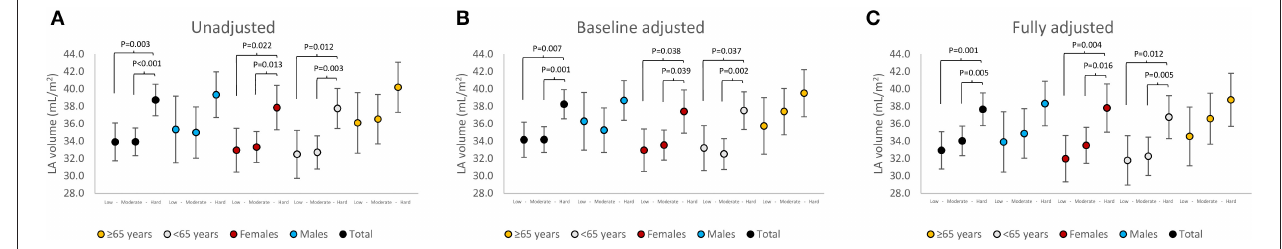
FIGURE 4 | Associations between cumulative PA and cross-sectional LA volume index (LAVi) in Tromsø7. (A) is unadjusted, (B) is adjusted for baseline LADi in Tromsø6, (C) is adjusted for baseline LADi in addition to age, sex, body mass index, and hypertension groups. Differences between groups of cumulative PA is indicated with p -values. Error bars indicate 95% CI. PA, physical activity; LA, left atrial; CI, confidence interval; LADi, LA diameter index.